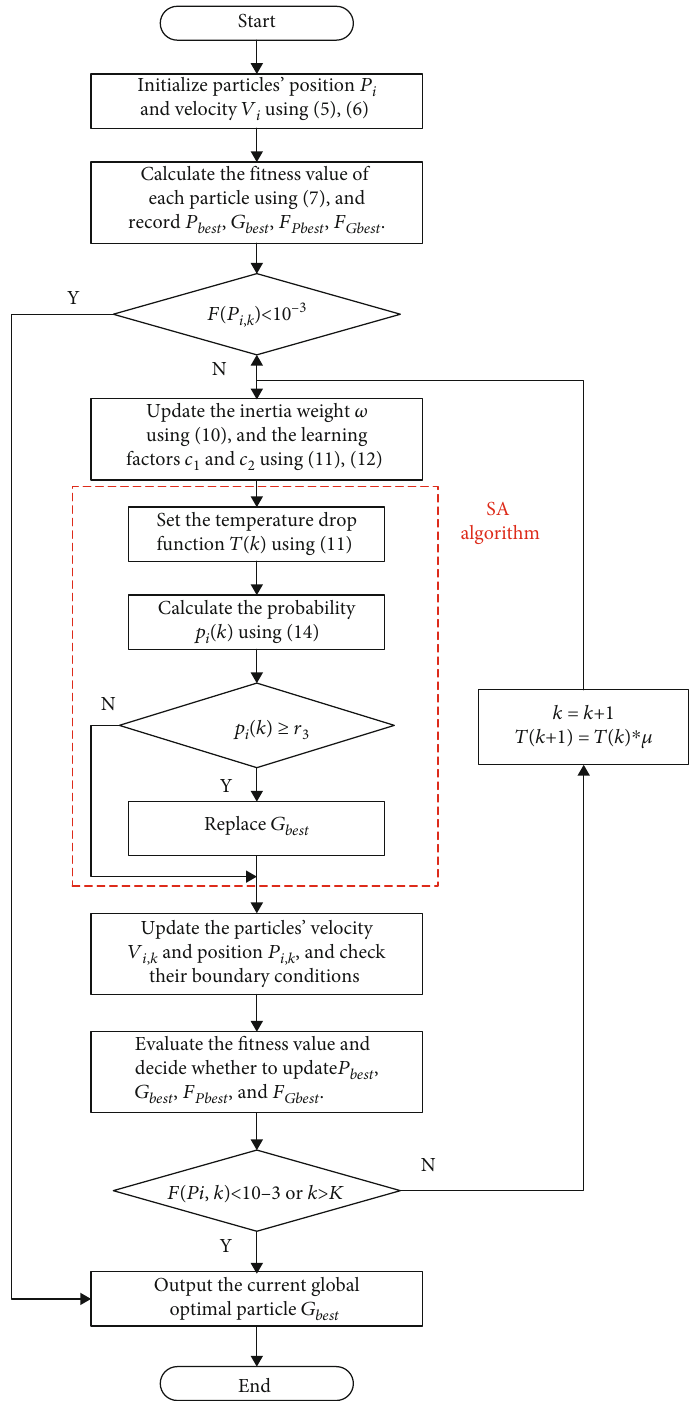
Figure 3: The fl ow chart of the SA-PSO